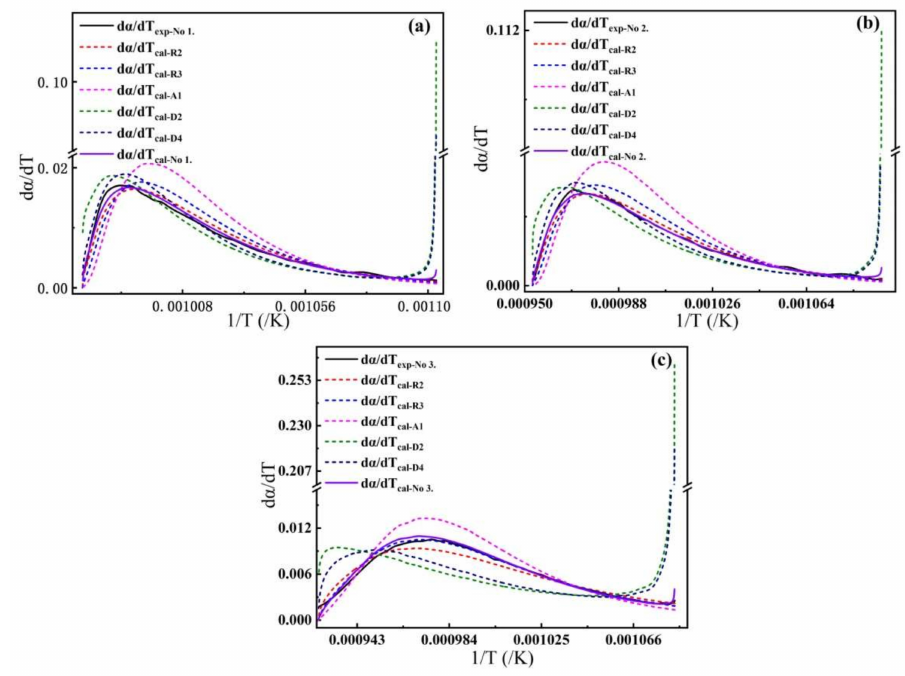
Figure 5. The relative error curves of the models corresponding to samples No.1, No.2, and No.3, respectively ( a – c